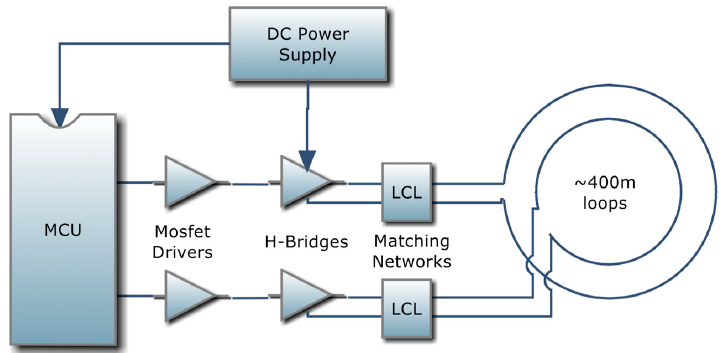
Figure 4. Schematic representation of the signal generation unit, where MCU and LCL respectively